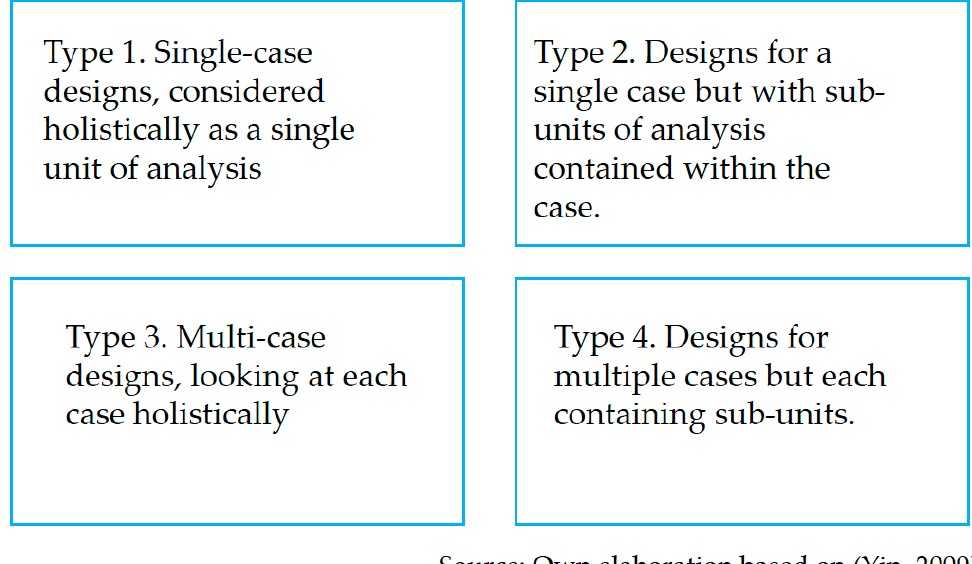
Figure 1. Types of design for case studies